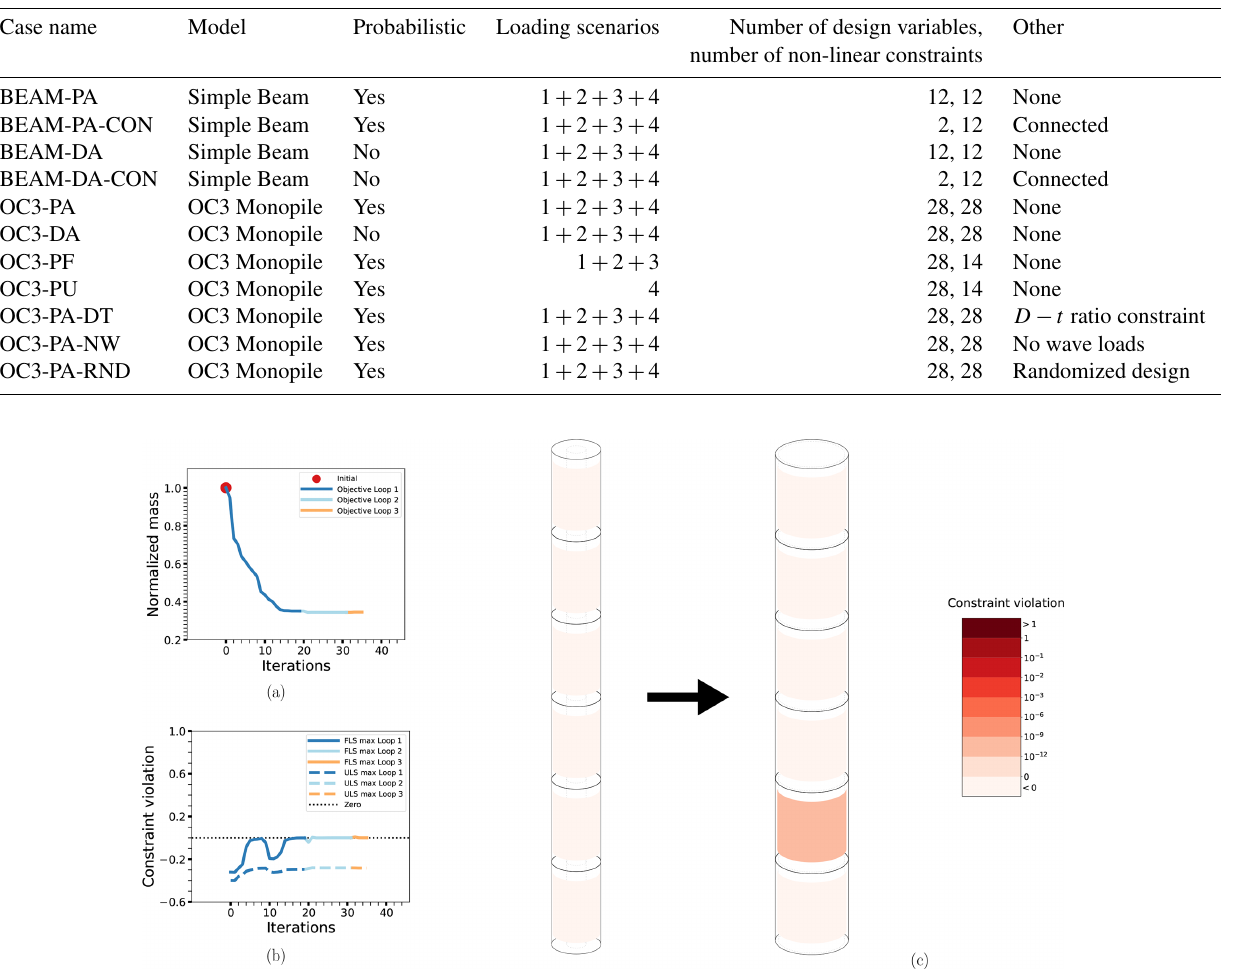
Figure 7. The optimization process for case BEAM-PA-CON: the objective function (a) , maximum non-linear constraint violations (b) and the change in the design from initial to final configuration (c) . The design drawings also have the level of non-linear constraint violation indicated by the coloring of the elements. The thicknesses have been exaggerated for legibility.